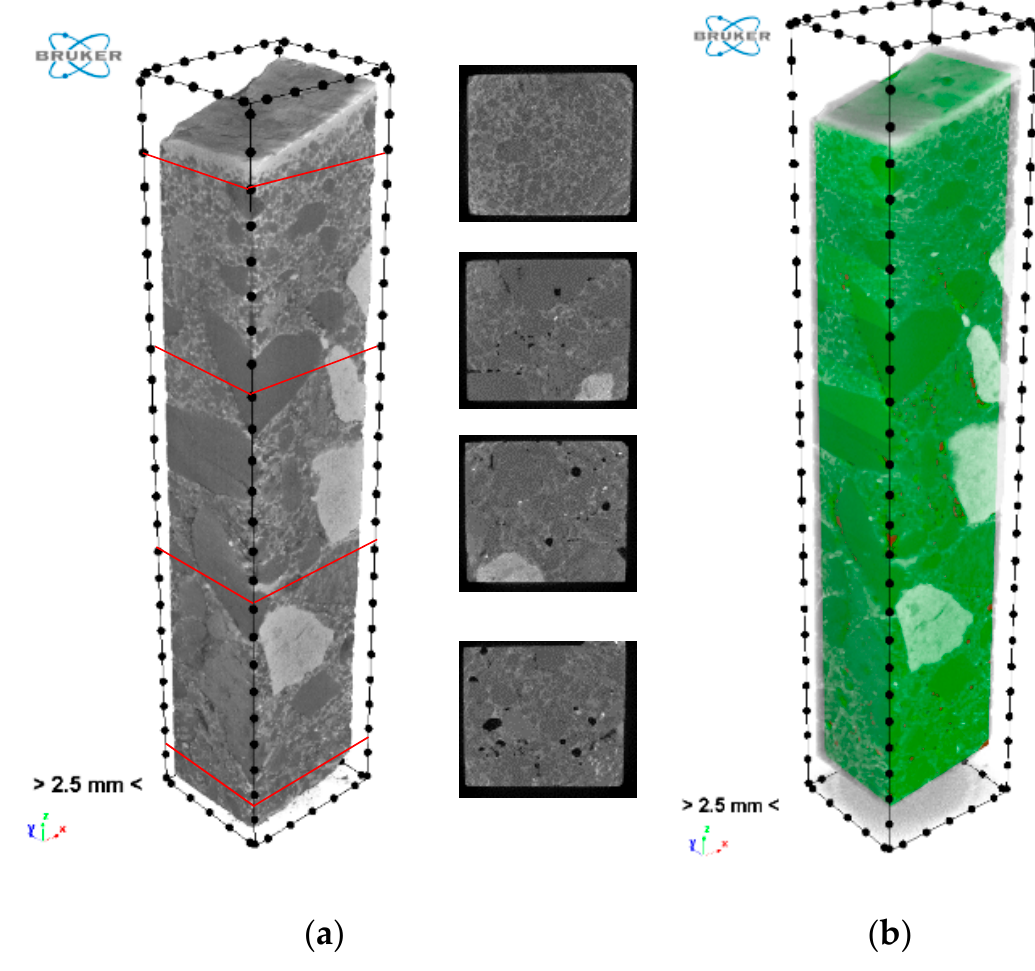
Figure 18. Reconstruction of the tested sample: ( a ) rendered three-dimensional (3D) view with exemplary cross-sections; ( b ) volume of interest (VOI) selection.